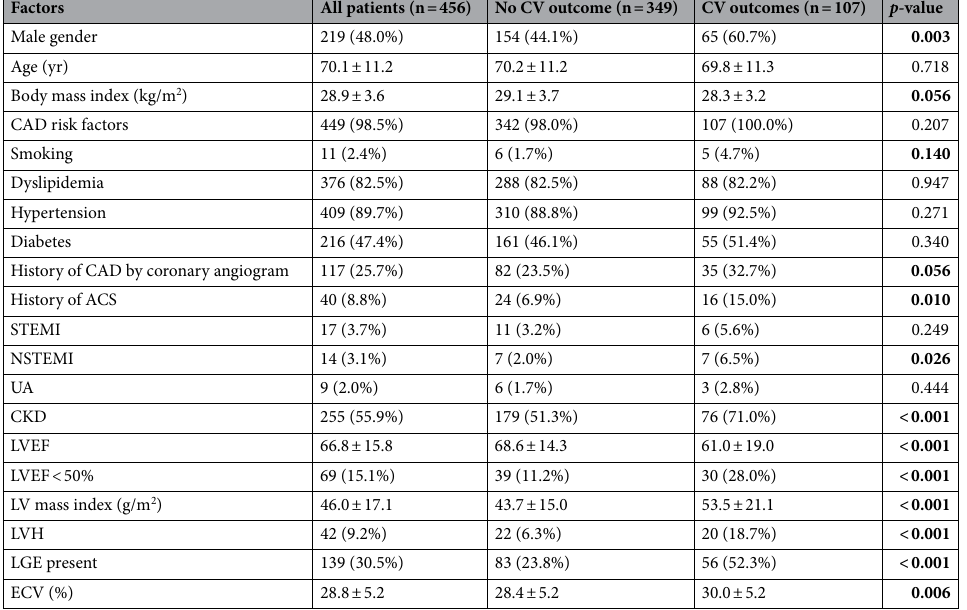
Table 1. Baseline characteristics of the study population and comparison between those with and without the composite cardiovascular (CV) outcomes. Data are presented as number and percentage or mean ± standard deviation. A p -value < 0.05 indicates statistical significance (bold). CAD, coronary artery disease; ACS, acute coronary syndrome; STEMI, ST-segment elevation myocardial infarction; NSTEMI, non-ST segment elevation myocardial infarction; UA; unstable angina; CKD, chronic kidney disease; CMR, cardiac magnetic resonance; LVEF, left ventricular ejection fraction; LVH, left ventricular hypertrophy; LGE, late gadolinium enhancement; ECV, extracellular